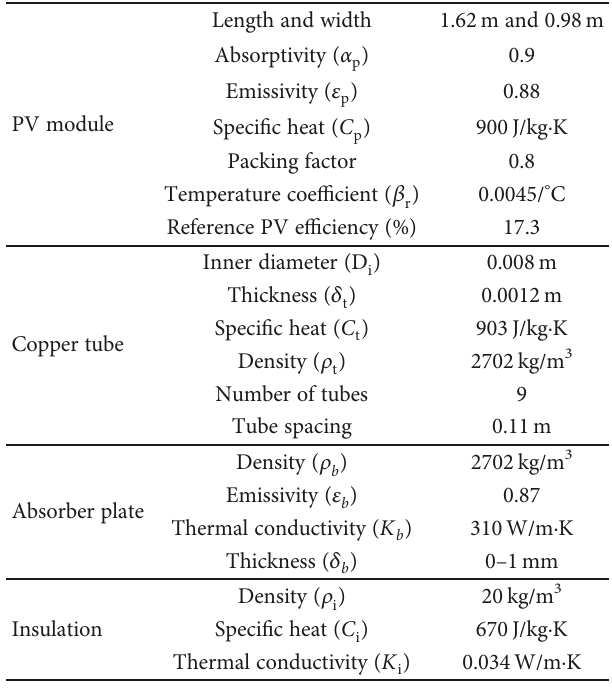
Table 2: Data for